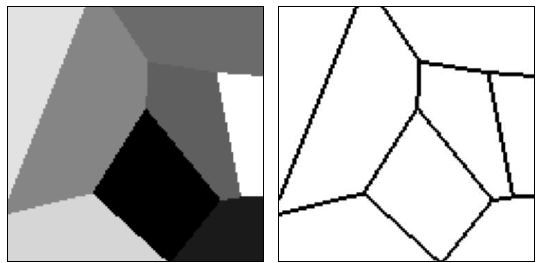
Figure 5. Example of mosaic structure and its associated borders.